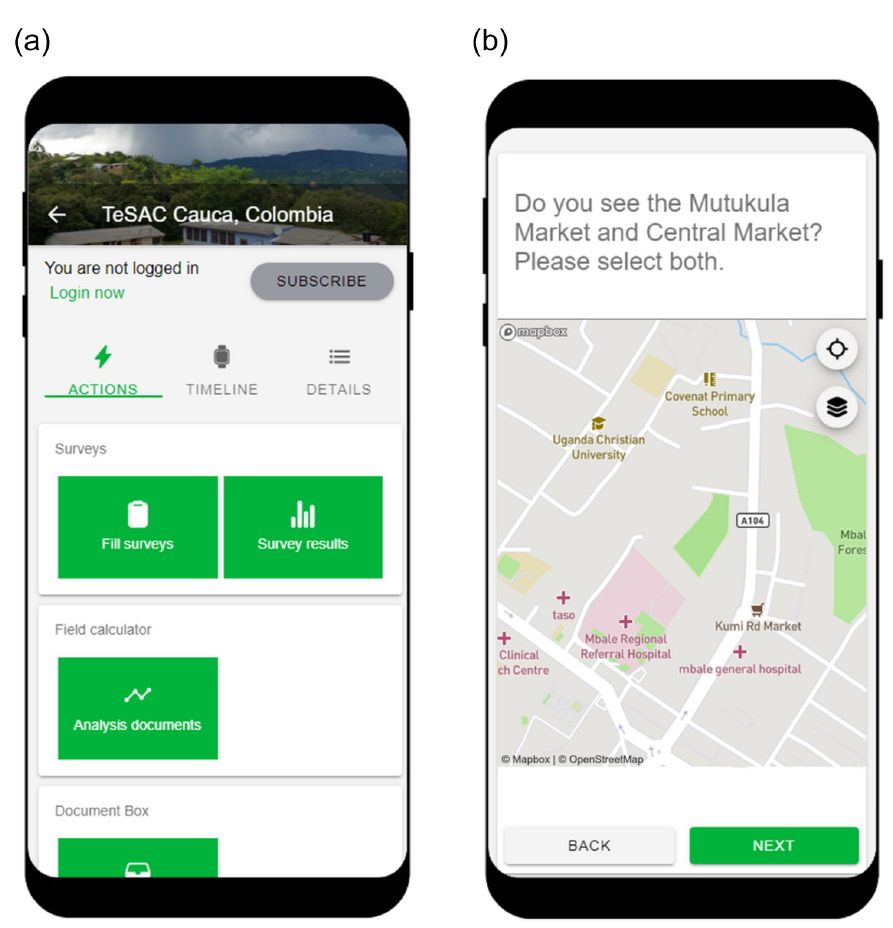
Fig 1. GeoFarmer application (note that permission to use the figure was obtained from Fundacio´n CEC; also note that the figure uses map data from Mapbox and OpenStreetMap and their data sources; see mapbox.com/ about/maps and